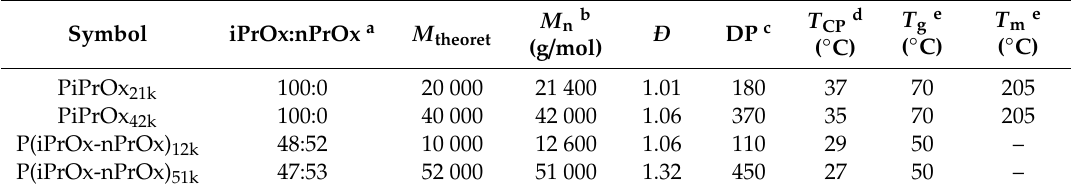
Table 1. Characterisation data of the obtained iPrOx-based